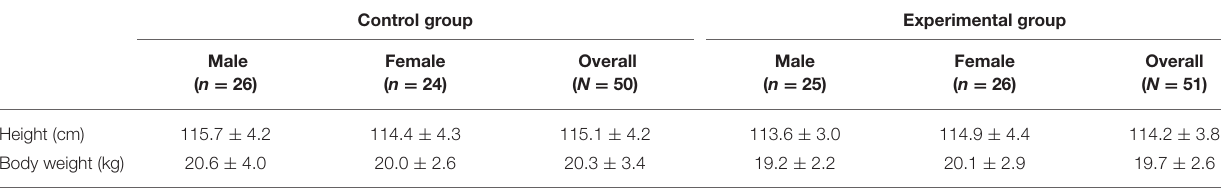
TABLE 1 | Children’s demographic characteristics.